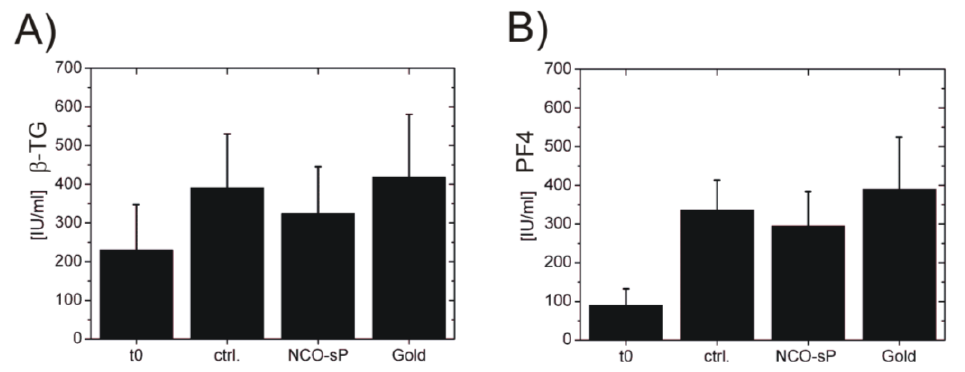
Figure 5. Plasma concentrations platelet activation markers. ELISA tests for  -thromboglobulin ( A ) and platelet factor 4 ( B ). Before (t0) and after 60 min of PRP incubation on the rocking platform, Sample without sensors (ctrl.), with NCO-sP(EO- stat -PO) coated sensors (NCO-sP(EO- stat -PO)) and uncoated gold sensors (Gold) each group 3 samples (n = 3) were